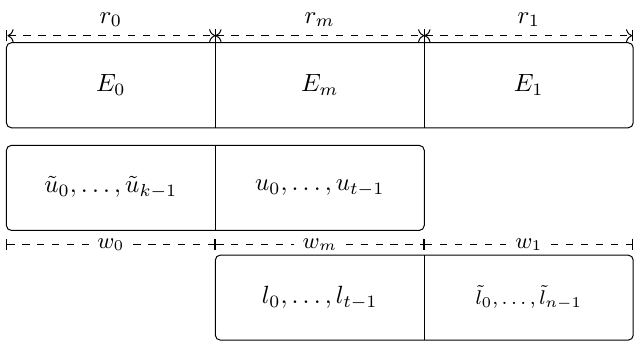
Figure 4: The variables of our MILP model to find truncated upper/lower